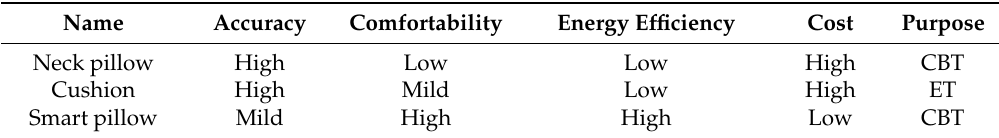
Table 4. Comparison of three temperature-related pillows. CBT: core body temperature; ET: environmental